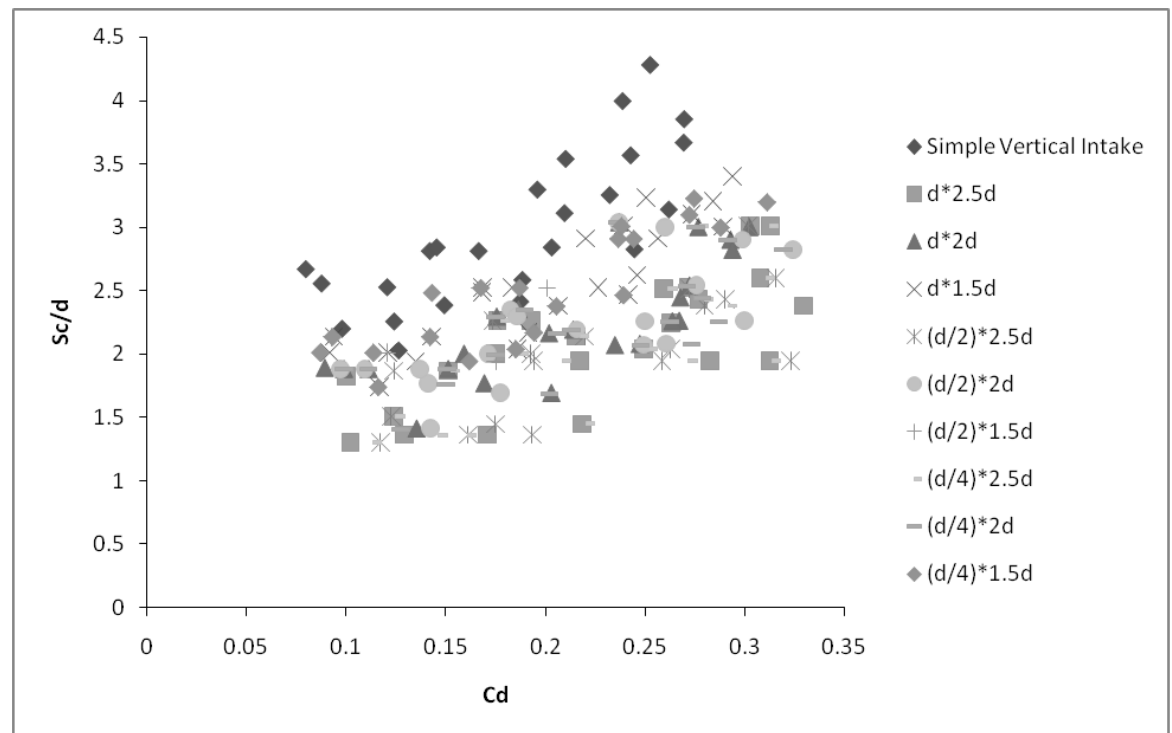
Fig. 3 Variation of discharge coefficient against the critical submergence ratio